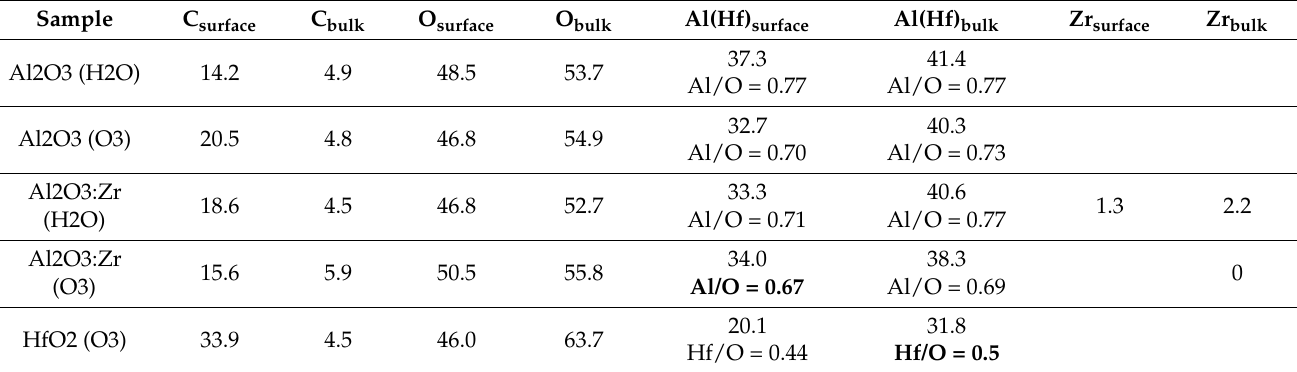
Table 1. Elements content (in at %) in investigated samples from XPS measurements of C 1s, O 1s and Al 2p, Hf 4f and Zr 3d lines. “Surface” is related to sample measure as received, “bulk” to sample after sputtering with Ar + ions with 1 kV energy. Sample C